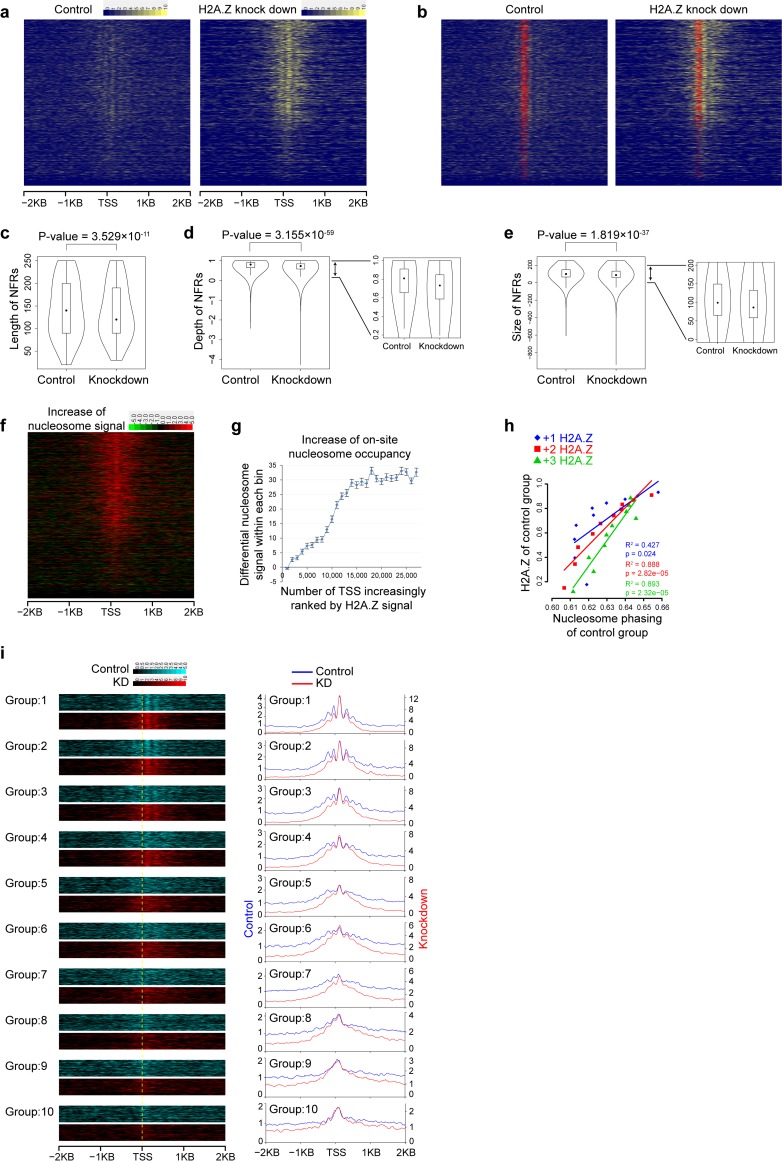
H2A.Z knockdown induced decrease of nucleosome free regions and nucleosome phasing at TSS regions.(a) Nucleosome profiles around TSSs in control group and H2A.Z knockdown group. TSSs are decreasingly ranked by their H2A.Z levels (the sum of normalized H2A.Z signal within -2000 to +2000 bp) in control group. (b) Nucleosome free regions (NFRs) marked in red color for control and knockdown groups. (c-e) Length (c), depth (d), and size (e) of nucleosome free regions. The median and quartile are shown. P-value was calculated by one-tailed t-test. (f) H2A.Z knockdown induced increase of nucleosome signals around TSS versus control group. The differential nucleosome profiles between H2A.Z knockdown and control group were calculated by DANPOS with the setting of “quantile normalization”. (g) Increase of “on-site” nucleosome occupancy on TSSs. TSSs are increasingly ranked by their H2A.Z levels in control groups, and the increase of “on-site” nucleosomes is plotted to show the mean ± SEM values within each bin of 1000 TSSs. Spearman correlation was calculated between the difference of “on-site” nucleosome occupancy at TSSs (the sum of differential nucleosome signals within -90 to +20 bp around TSS) versus the H2A.Z level (the sum of H2A.Z normalized-signals within -2000 to +2000 bp around TSS) of the corresponding TSSs in control group. (h) Cross-group linear regression for H2A.Z levels versus the nucleosome Phasing Index of control sample. Adjusted R2 and p-values are labeled on the panels. (I) Comparison of nucleosome profiles between control and knockdown samples. Nucleosome profiles are aligned within -2000 to +2000 bp around TSSs in a 10 bp resolution. TSSs (>20000 TSSs having non-zero H2A.Z signals at “+1” nucleosomes) are decreasingly ranked by H2A.Z levels at “+1” nucleosomes, and evenly divided into 10 groups.